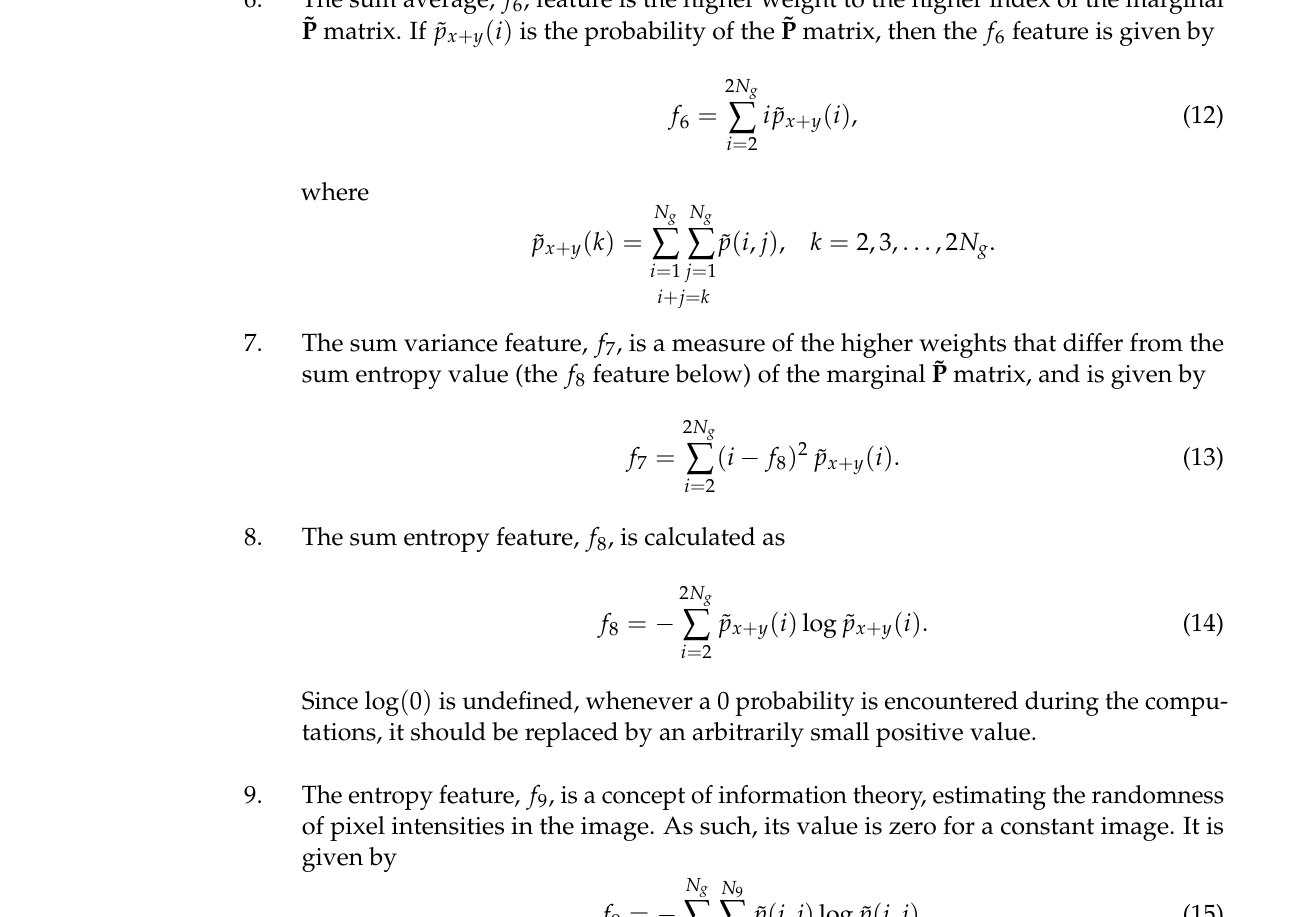
6 feature is given by